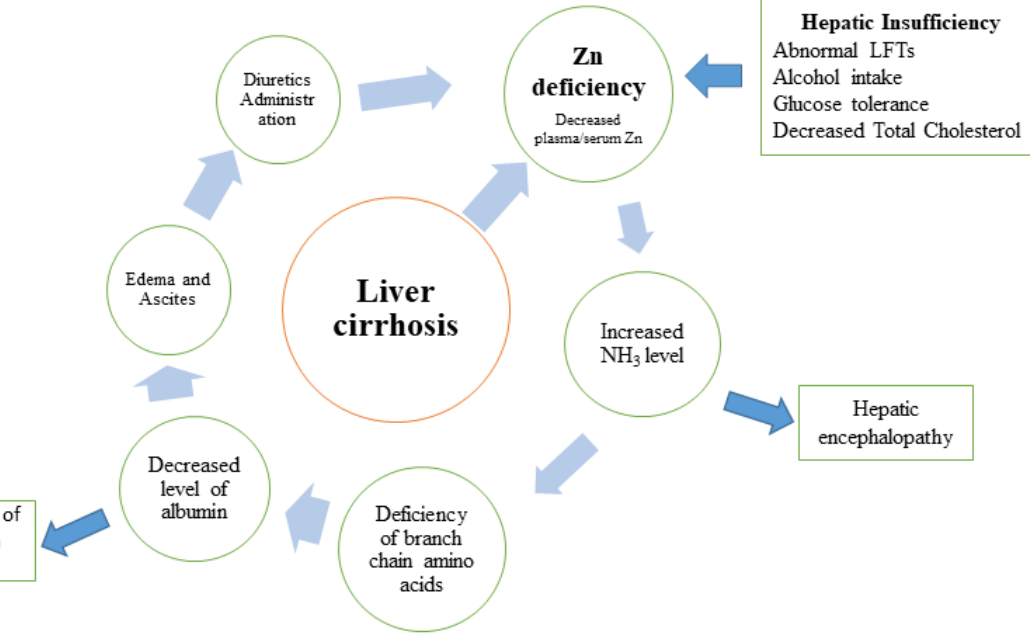
Figure 3. Zinc de fi ciency and liver cirrhosis. Figure 3. Zinc deficiency and liver